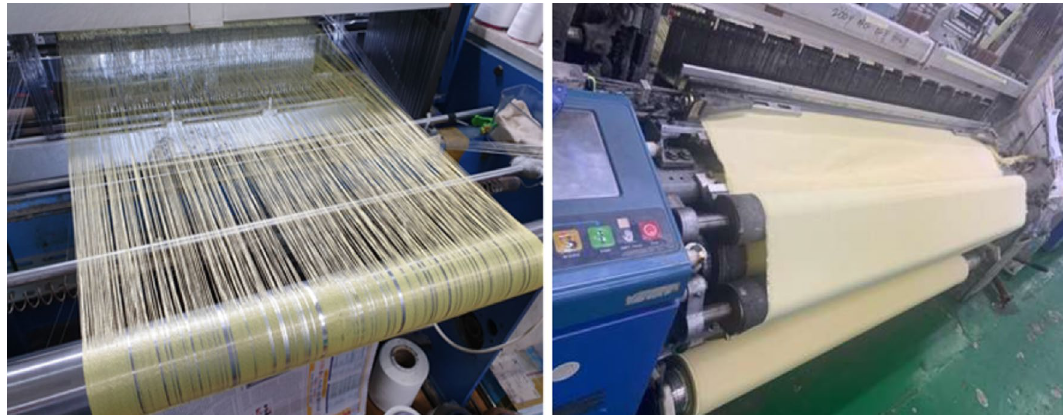
Figure 3. Para-aramid double-weave fabric weaving process.